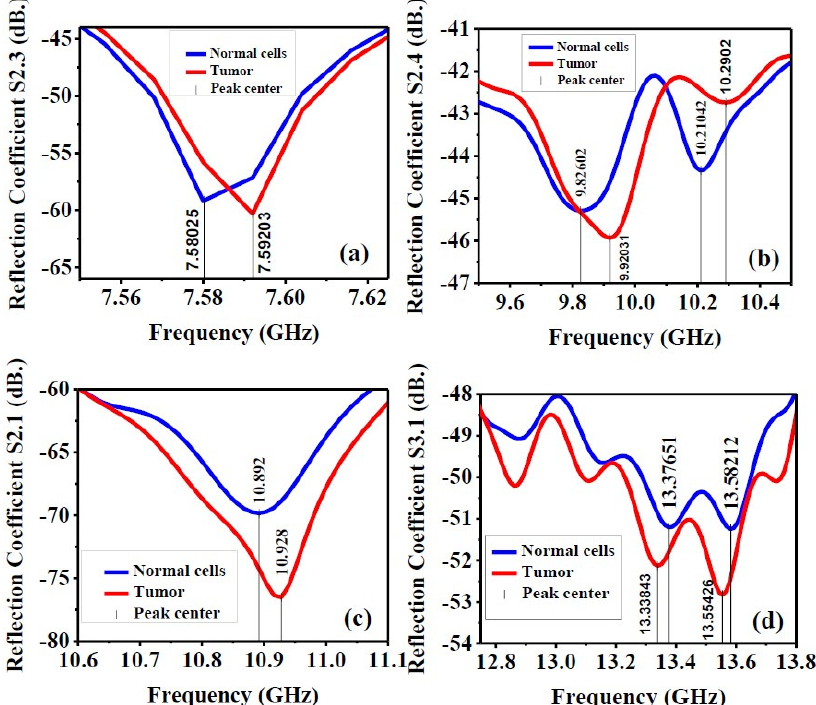
Figure 16. Reflection coefficient with the presence of tumor inside breast phantom: ( a ) S2.3, ( b )